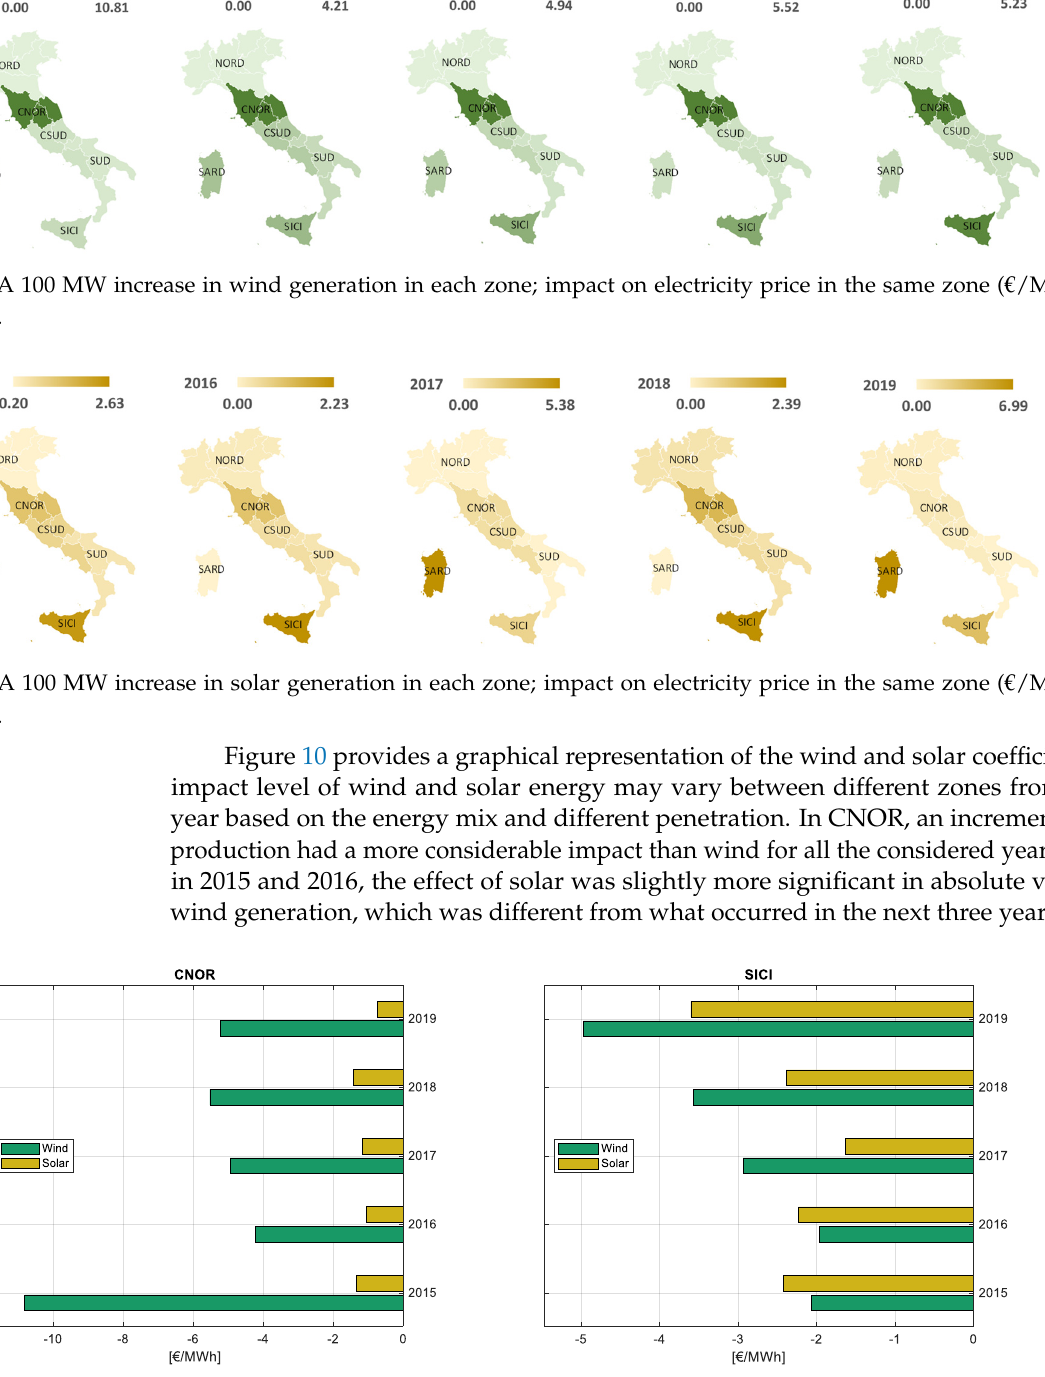
Figure 10. Impact of 100 MW increases in wind and solar generation on the zonal electricity price in CNOR and SICI; 2015 to 2019.